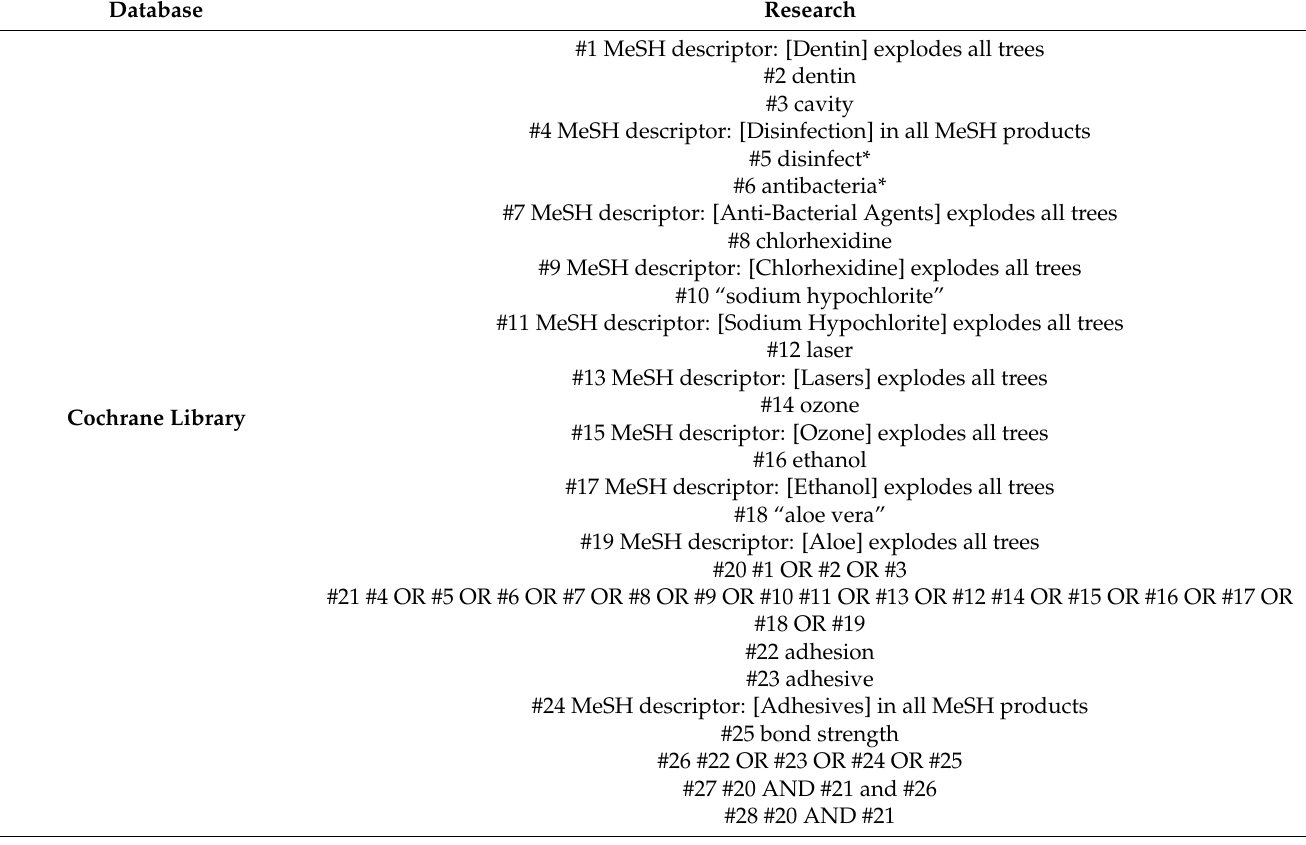
Table 3. Search keys used in the different databases. The asterisk represents any group of characters.